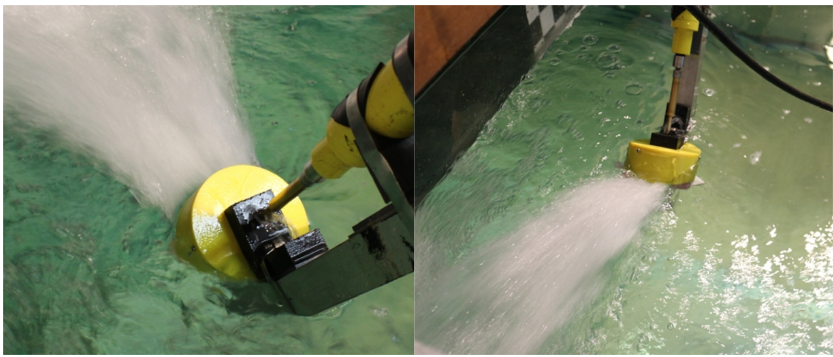
Figure 24. PJ jet during